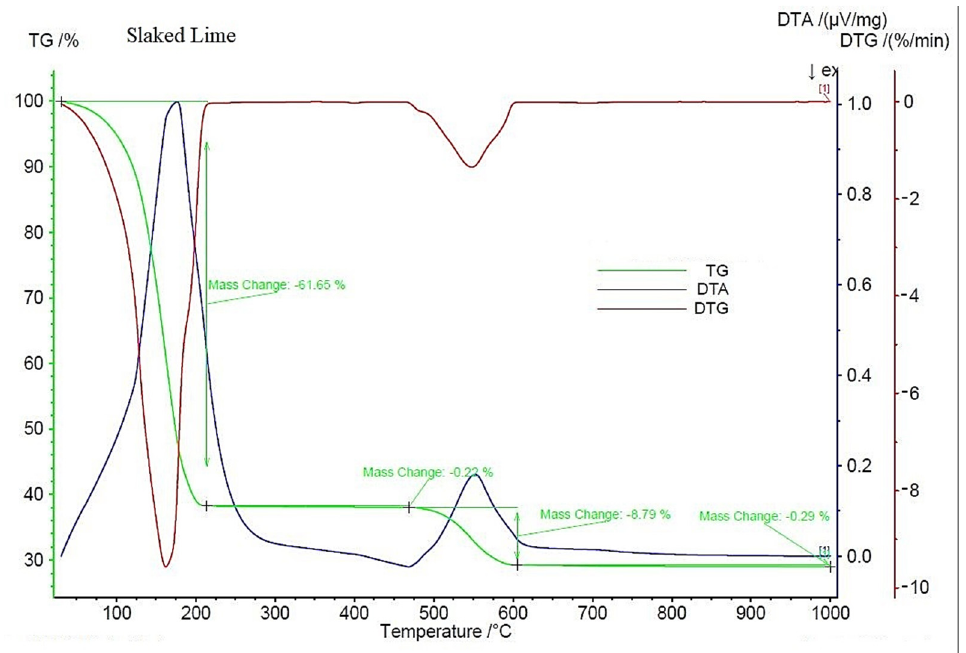
Figure 6. X-Ray diffractograms of kilned marble slurry ( above ) and slaked lime ( below ). As expected, XRD patterns highlight the conversion of marble slurry to lime and portlandite after kiln heating and slaking, respectively. STA performed on slaked lime (Figure 7) indicates that after 10 days an almost complete conversion of Calcium Oxide to Calcium Hydroxide occurred.